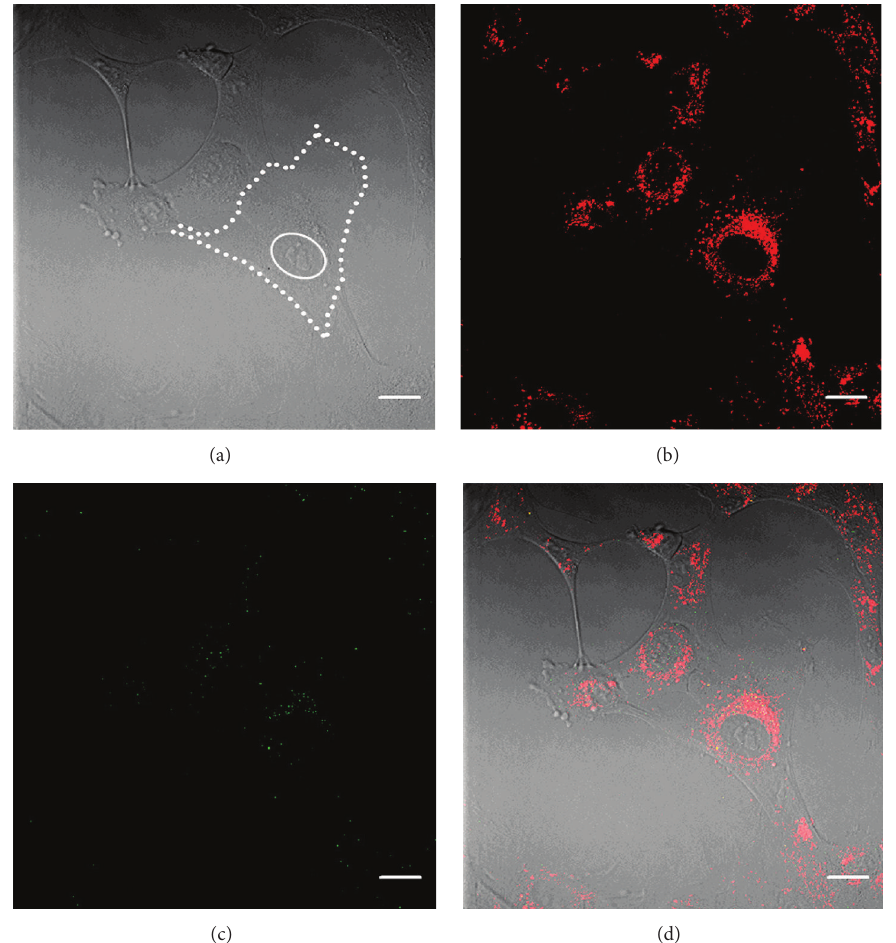
Figure 6: Autofluorescence originates from the perinuclear organelles in WJ-MSCs. (a) Bright field image of explant-derived WJ-MSCs. For reference, the cell boundary is delineated by a dotted white line and the nucleus is outlined by a full white line. (b) AF signal (red) and (c) SHG after two-photon excitation of the same cells. (d) Merged image. A perinuclear area of organelles is visible (view also the electronic Supplementary Material, Figure S2). Scale bars = 20 𝜇